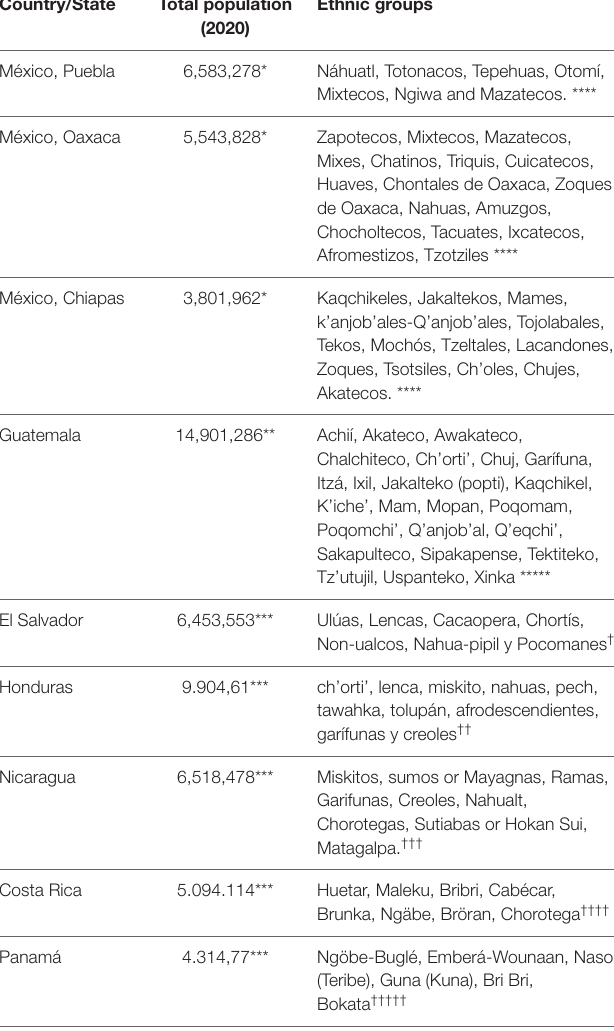
TABLE 1 | Human population and ethnic groups of SMP by country and state